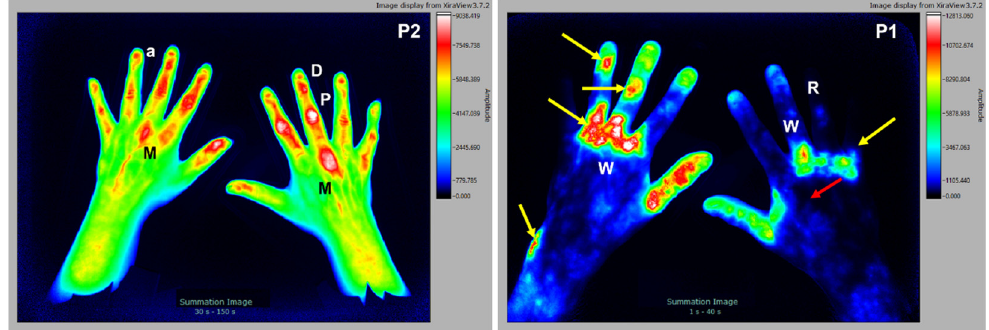
Figure 7. Left panel: the 37 y/o female patient with psoriasis arthritis. Signal enrichment is seen in DIP (D), PIP (P), MCP (M), and sigmoid patterns (a) below the nail bed. Right panel: the 45 y/o male patient with psoriasis vulgaris. Cloudy signal enrichment (W) is seen at the back of the hands and forearms, and in the psoriasis plaques (yellow arrows) with decreased signal in keratinized plaque (red arrow), as well as Raynaud’s syndrome (R).